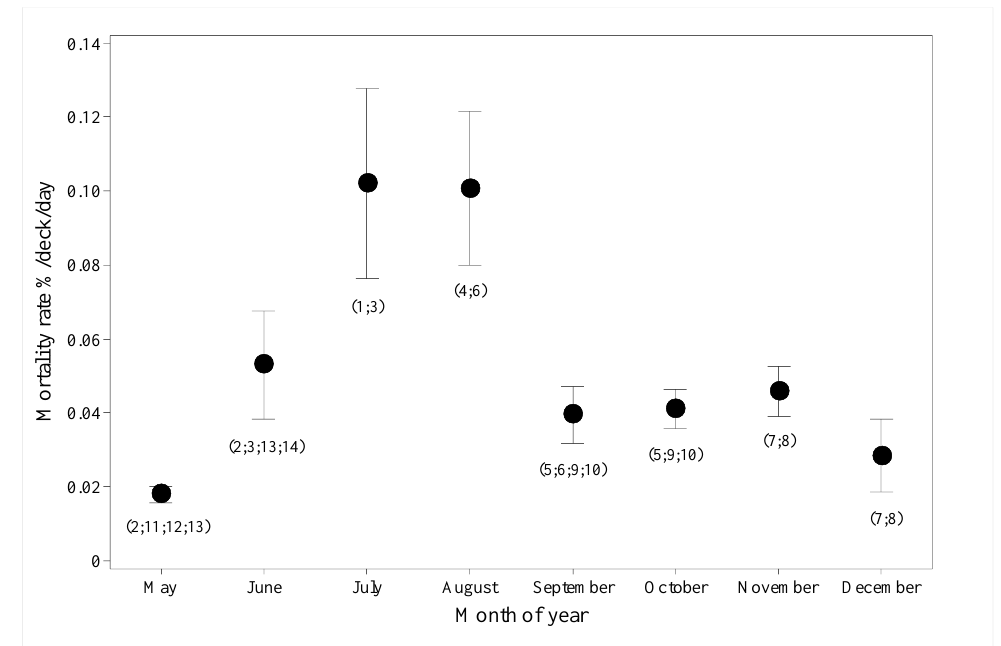
Figure 4. Mortality rate (%/deck/day) for the different months of the voyages ( n = 14, voyage numbers in parentheses) departing from May to December. Several voyages spanned two months.